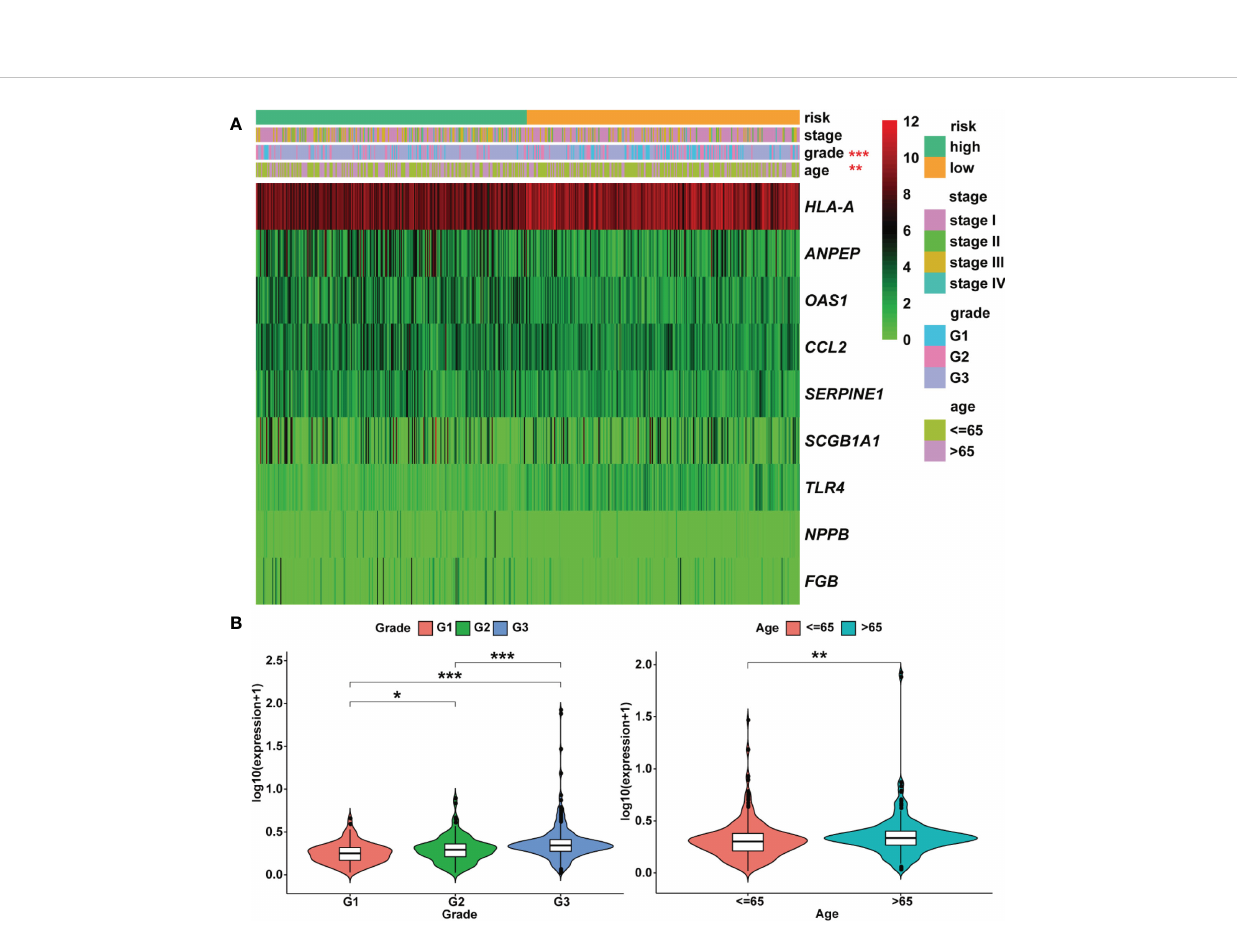
FIGURE 7 Heatmap and clinicopathologic parameters. (A) The clinical heatmap of 9 risk prognostic genes. (B) The risk scores were higher in the grade 3 and older patients. * means P < 0.05; ** means P < 0.01; *** means P <